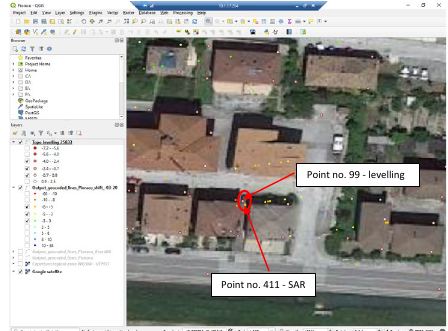
Figure 11. Identification of points for pointwise analysis: no. 99 from topographic levelling and the proximal no. 411 from